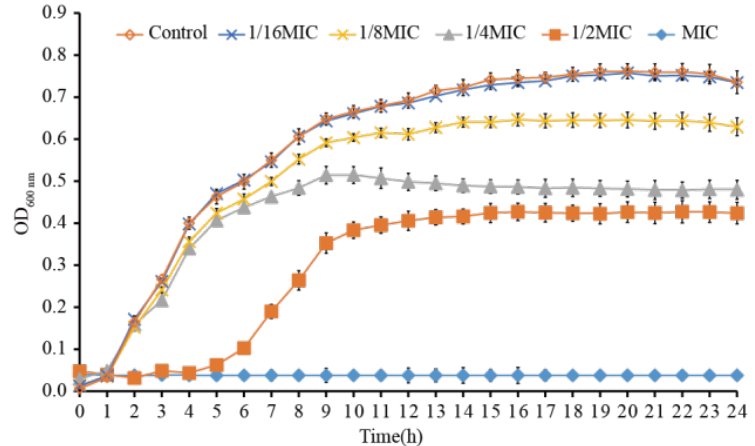
Figure 1. Growth curves for C. sakazakii in TSB with various concentrations of LC-EO.